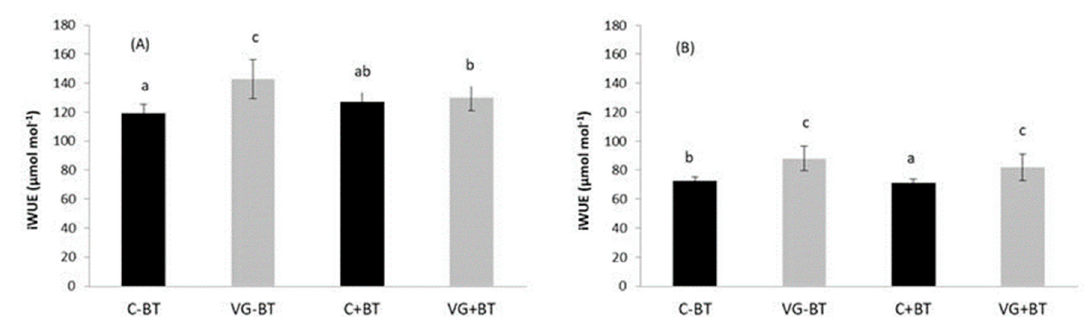
Figure 4. Intrinsic water use e ffi ciency (WUEi) calculated at harvest as A / gs measured in the years 2013 ( A ) and 2014 ( B ) on fully expanded Falanghina leaves sprayed with anti-transpirant Vapor Gard ® (VG) at 2% or left unsprayed (C) with or without bunch thinning (BT). Data are averages of 10 replicates ± SE. Same letter indicates not significant di ff erences at Duncan post hoc test ( p <